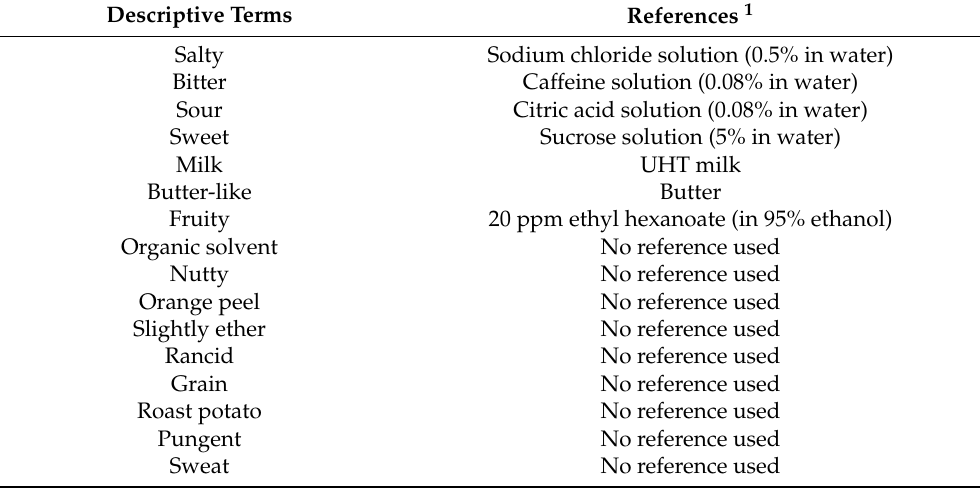
Table 7. Reference samples and descriptive terms used for flavor profiling of EMC